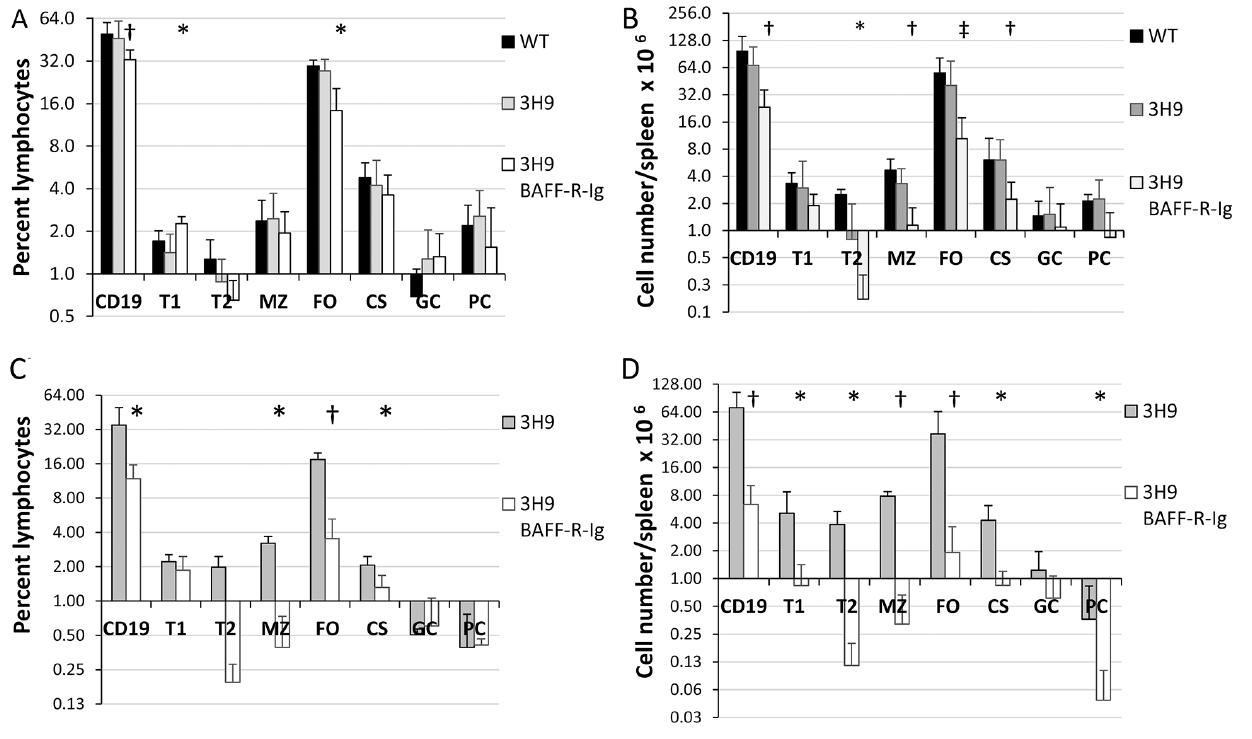
Figure 2. BAFF-R-Ig treatment depletes naive B cells. (A, C) Frequency of each B-cell subset as a percentage of total lymphocytes in NZW/BXSB male (A) and NZB/W female (B) chimeras. Four to eight mice were examined per group (* p < 0.05; † p < 0.01; ‡ p < 0.001). (B, D) Total number of B cells in each subset per spleen. n = 4–8 per group; * p < 0.05; † p < 0.01; ‡ p < 0.001, 3H9 untreated versus 3H9 BAFF-R-Ig–treated chimeras (T1, T2, transitional type 1 and 2 B cells; MZ, marginal zone; FO, follicular; CS, class switched; PC, plasma